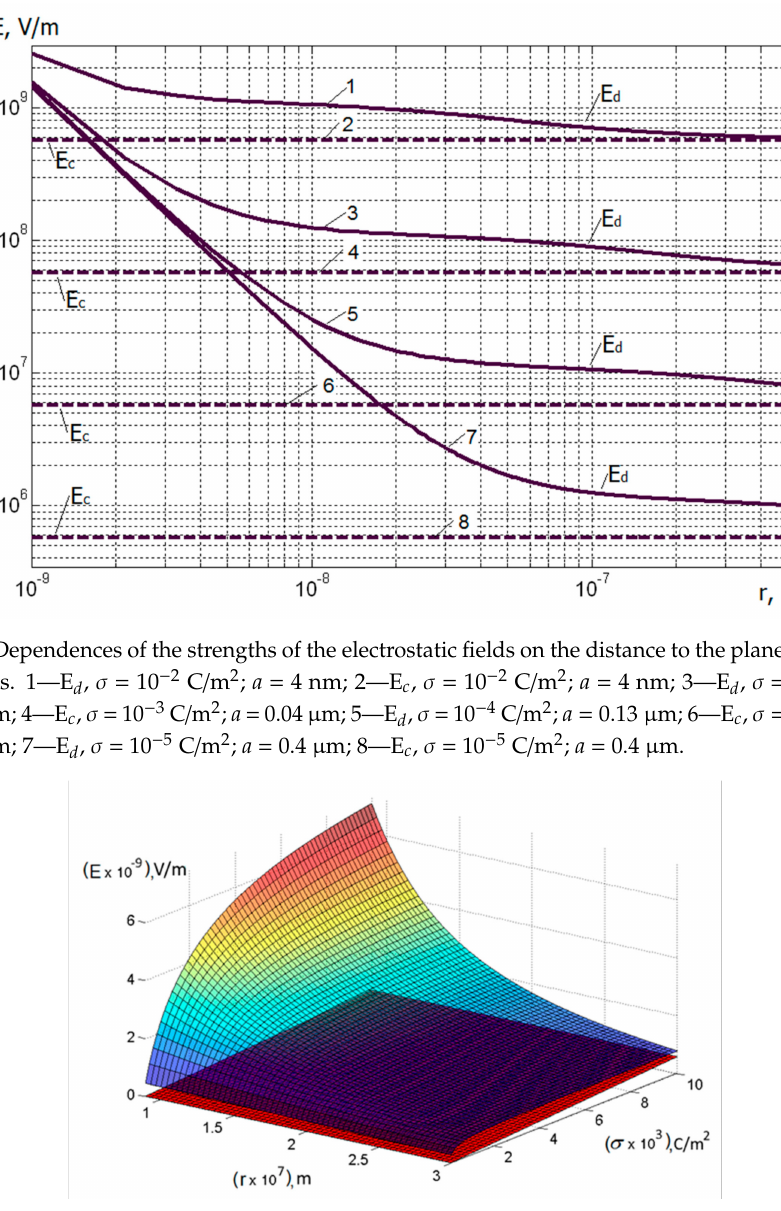
Figure 3. Dependences of the electrostatic fields strengths on the distance to the plane and the surface charge density (the red plane corresponds to a continuous charge distribution, a curved surface—to a discrete